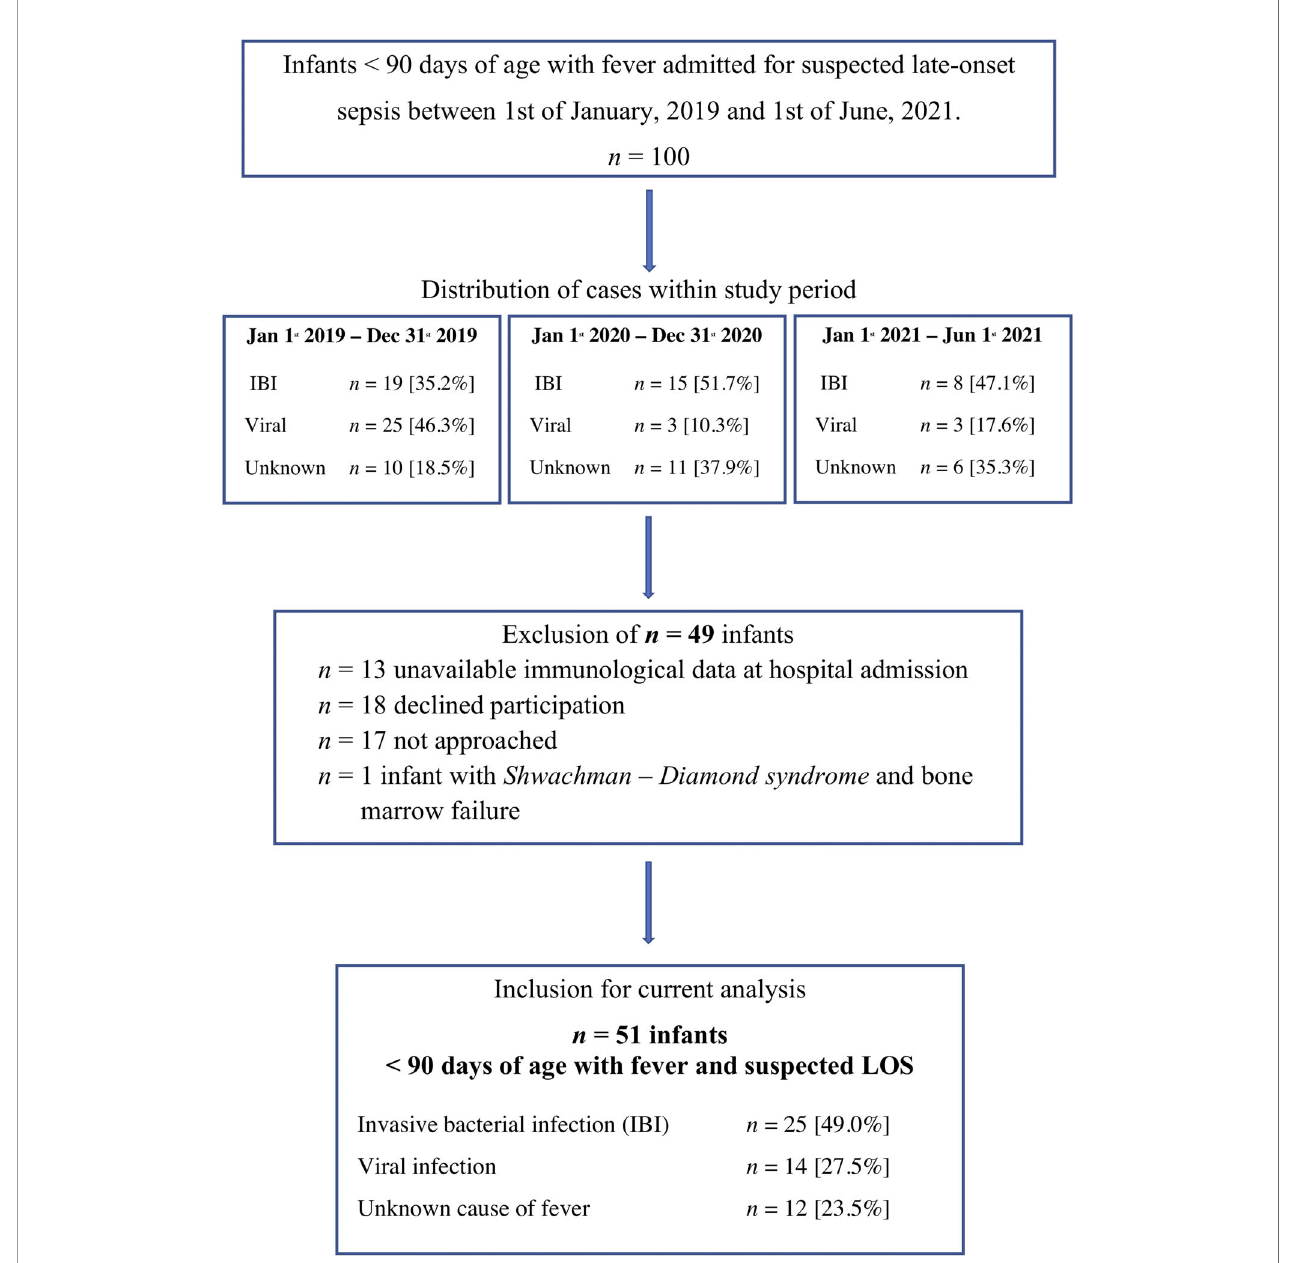
FIGURE 1 | In- and exclusion criteria for the current analysis. IBI, Invasive bacterial infection; Unknown, unknown sourcse of fever; Viral, viral infection. The chronological case distribution demonstrates a signi fi cant decline in viral infections that is diagnosed in infants < 90 days of age with suspected LOS in the